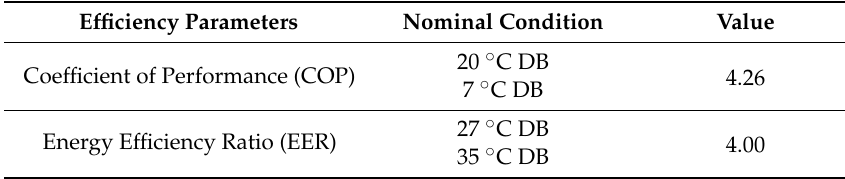
Table 1. Heat pump